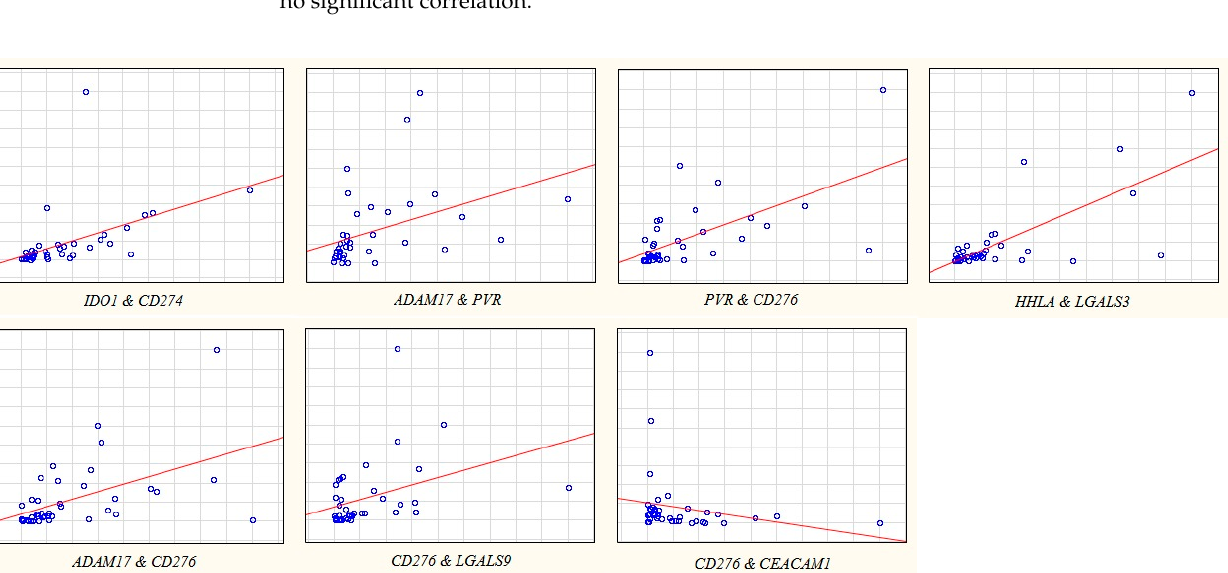
Figure 4. Scatterplot of gene expression at stage I + II (early GC).